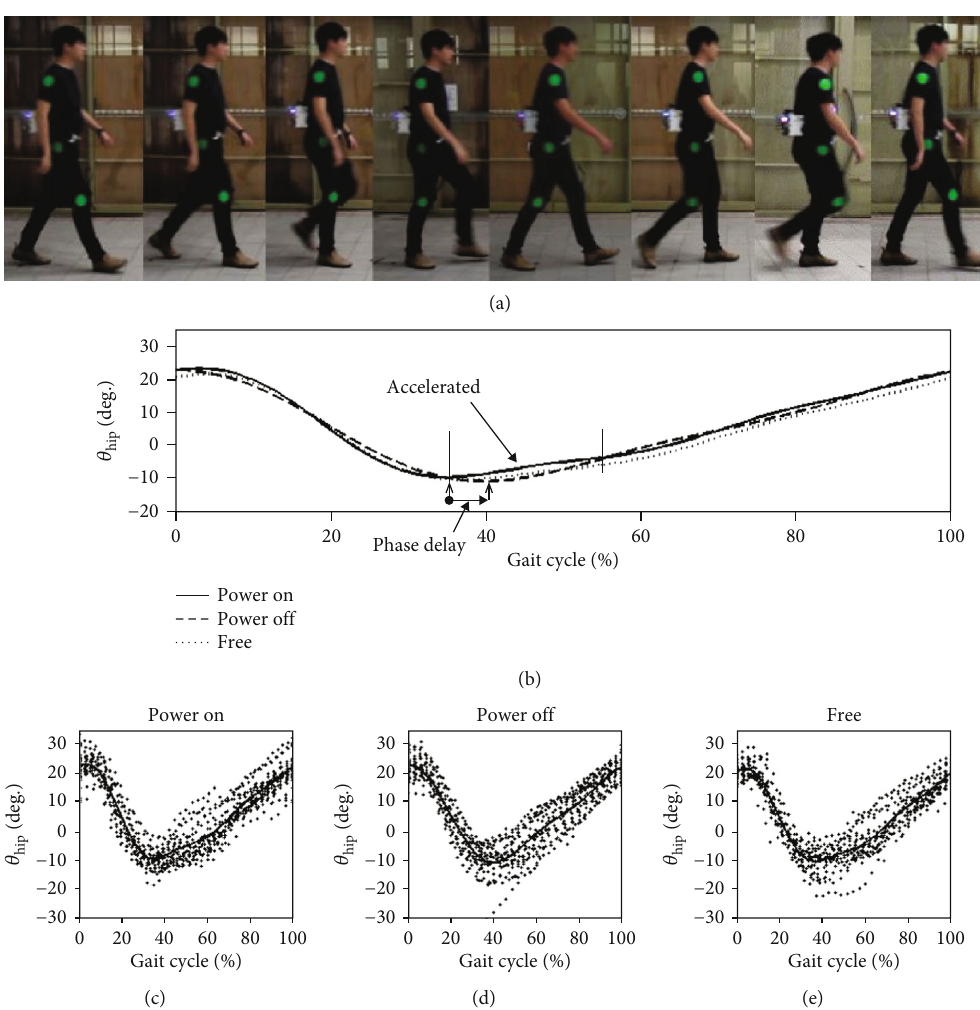
Figure 14: (a) Photograph of the gait motion measured using the video camera. (b) Averaged gait motions for the cases in which the soft exoskeleton is worn with its power switched on, is worn with its power switched o ff , and is not worn. An assistive force was provided by the soft exoskeleton during the preswing phase. (c, d, e)All gait motions for each